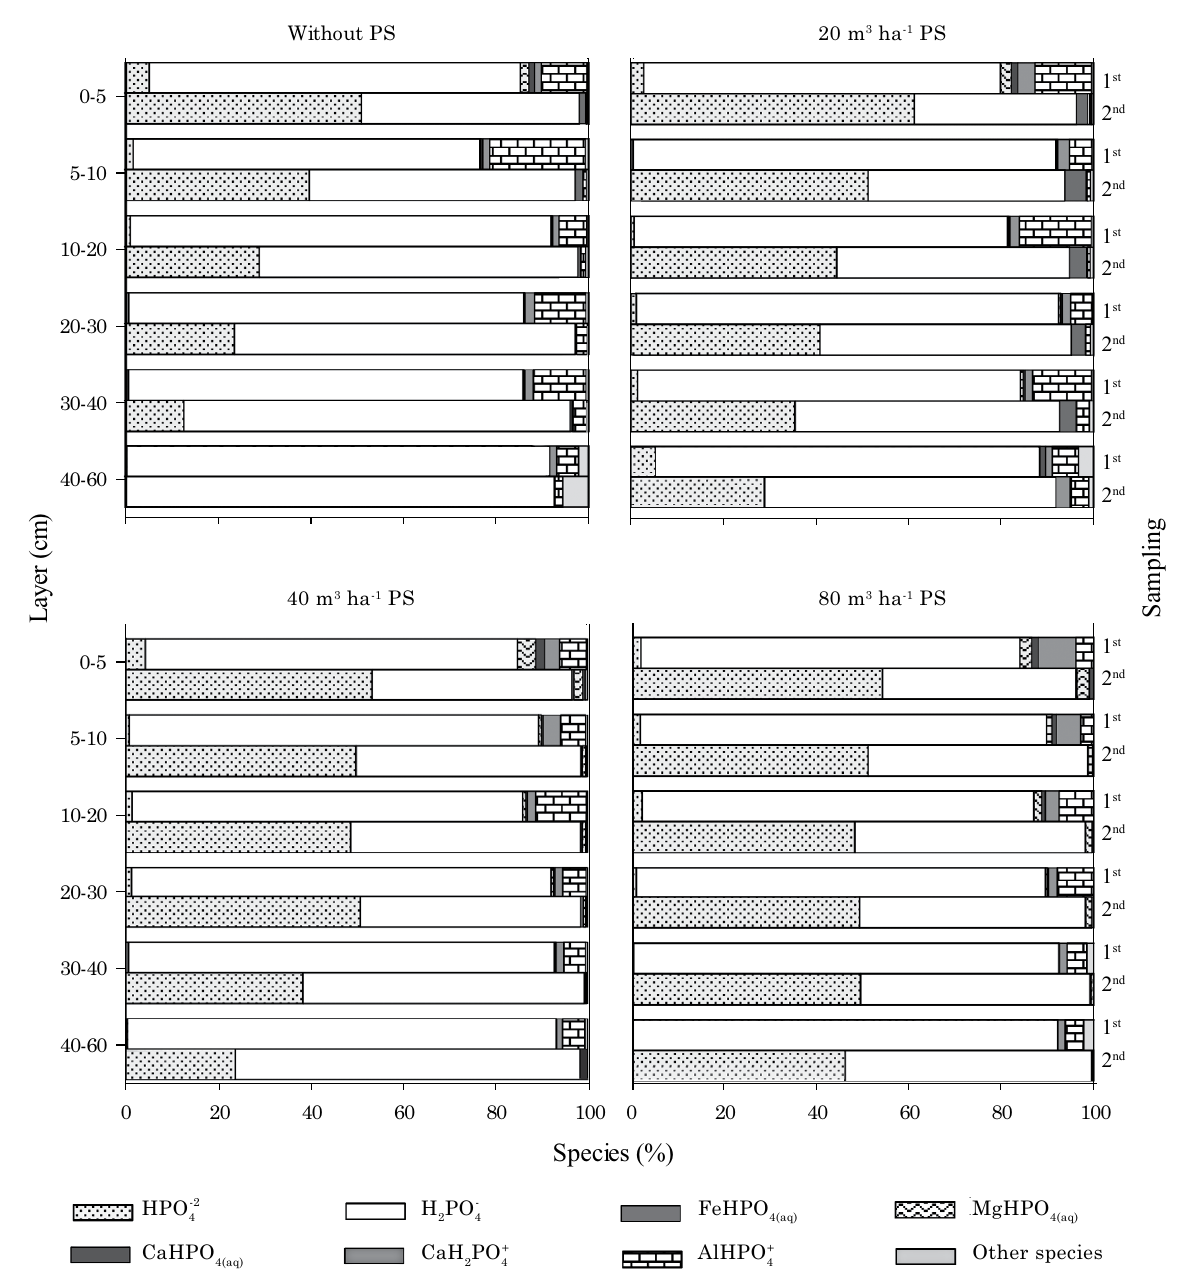
figure 2. chemical species of P in the 1 st and 2 nd sampling in the solution of a typic hapludalf soil in response to the application of 0, 20, 40, and 80 m 3 ha -1 of pig slurry (Ps). other species correspond to h 3 Po 4 , feh 2 Po 4+ , Kh 2 Po 4(aq) , caPo 4- , mnhPo 4(aq) , and Al 2 Po 43+